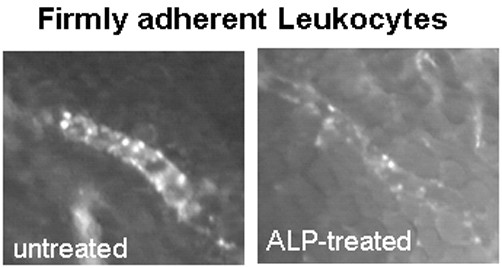
Imaging of adherent leukocytes in vivo. The figure shows a representative fluorescence microscope image (original magnification × 306) of a postcapillary venule showing an increased number of cells adhering to the wall of the postcapillary venule in a control animal that received the anti-collagen II (CII) antibodies and a pre-treatment with NaCl compared to an antileukoproteinase-treated mouse at 24 hours after anti-CII mAb transfer.